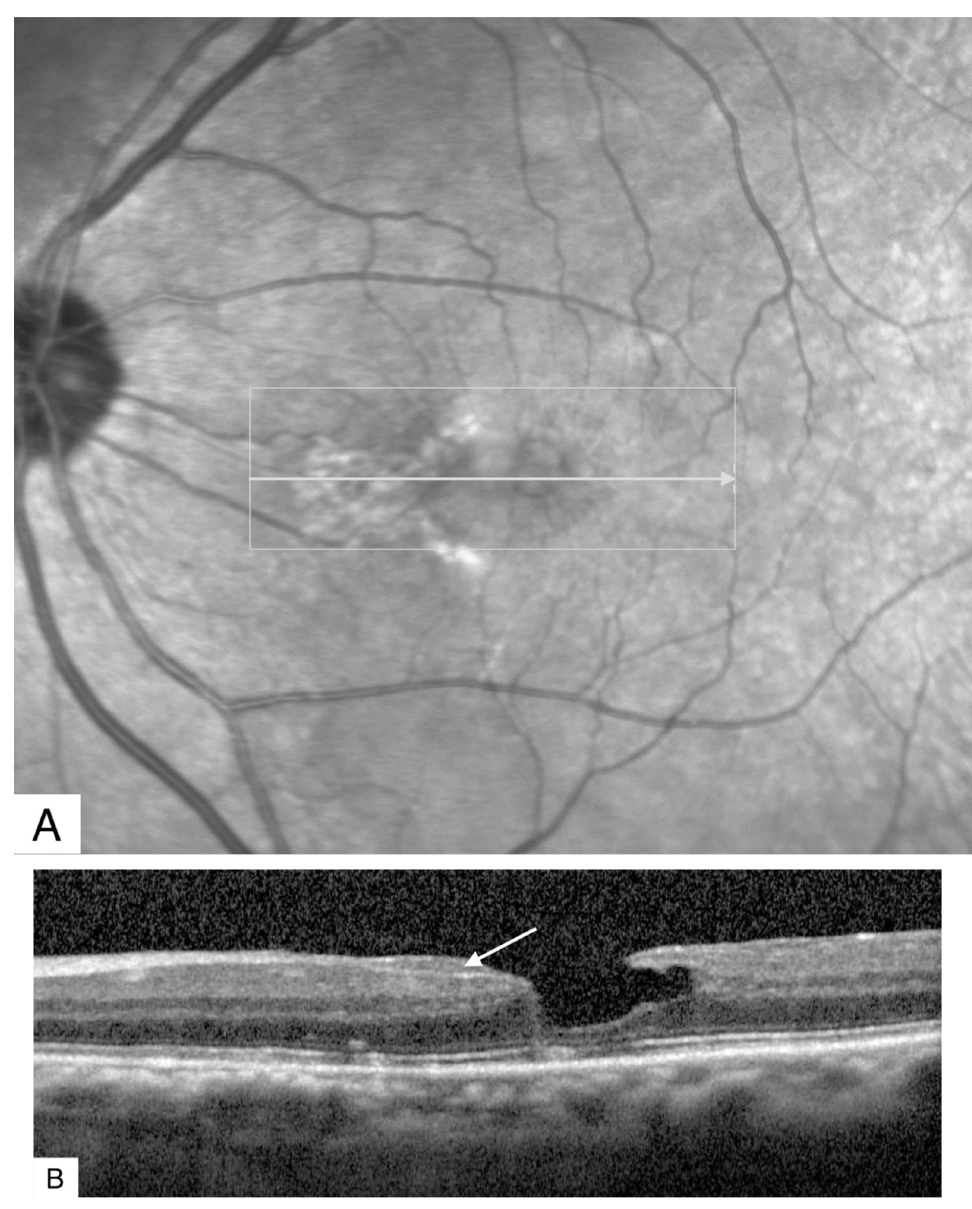
Figure 3. ( A ) Infrared reflectance imaging of an eye demonstrating alterations in the fovea. The horizontal arrow shows the direction of the SD-OCT scan. ( B ) SD-OCT scan showing epiretinal proliferation (arrow) that is isoreflective and conforms to the retinal surface without altering the retina shape. There is no evidence of traction. The foveal contour is irregular. SD-OCT: Spectral domain optical coherence tomography.